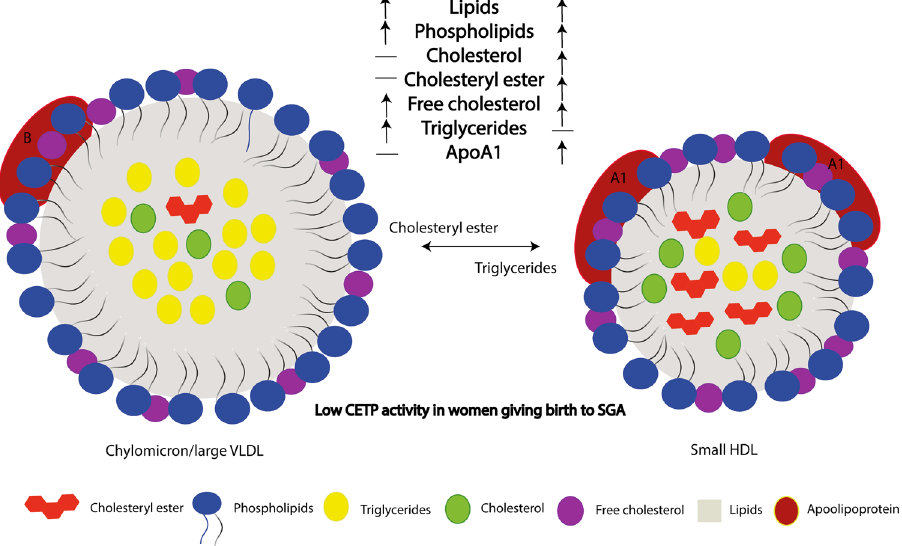
Figure 7. Illustration of the main findings. Low CETP activity in the circulation of women giving birth to SGA infants, followed by low cholesteryl ester and triglyceride exchange between chylomicron/large VLDL and small HDL, resulting in high triglycerides, lipids, phospholipids and free cholesterol in the chylomicrons/large VLDL and high phospholipids, lipids, cholesteryl ester, cholesterol, free cholesterol and ApoA1 in the small HDL compared to the composition in women giving birth to AGA